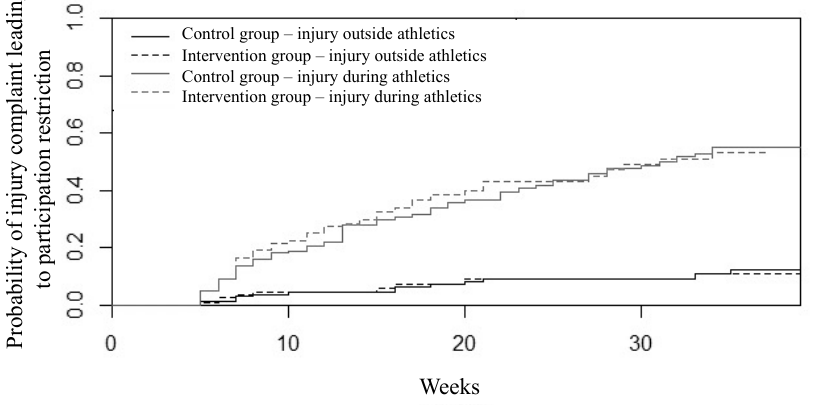
Figure 3. Cumulative incidence curves for the intervention (dotted line) and control (full line) groups for the probability of ICPR occurred during athletics (in grey) and outside of athletics (in black).